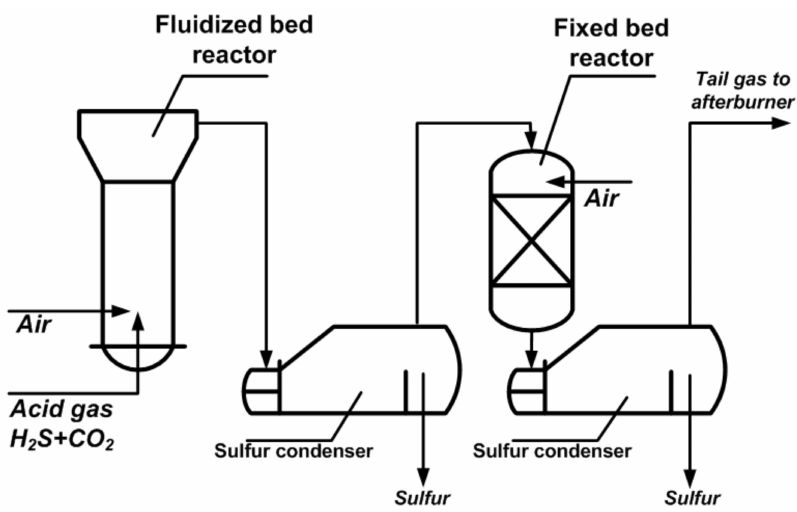
Figure 31. Schematic diagram of the alternative direct oxidation